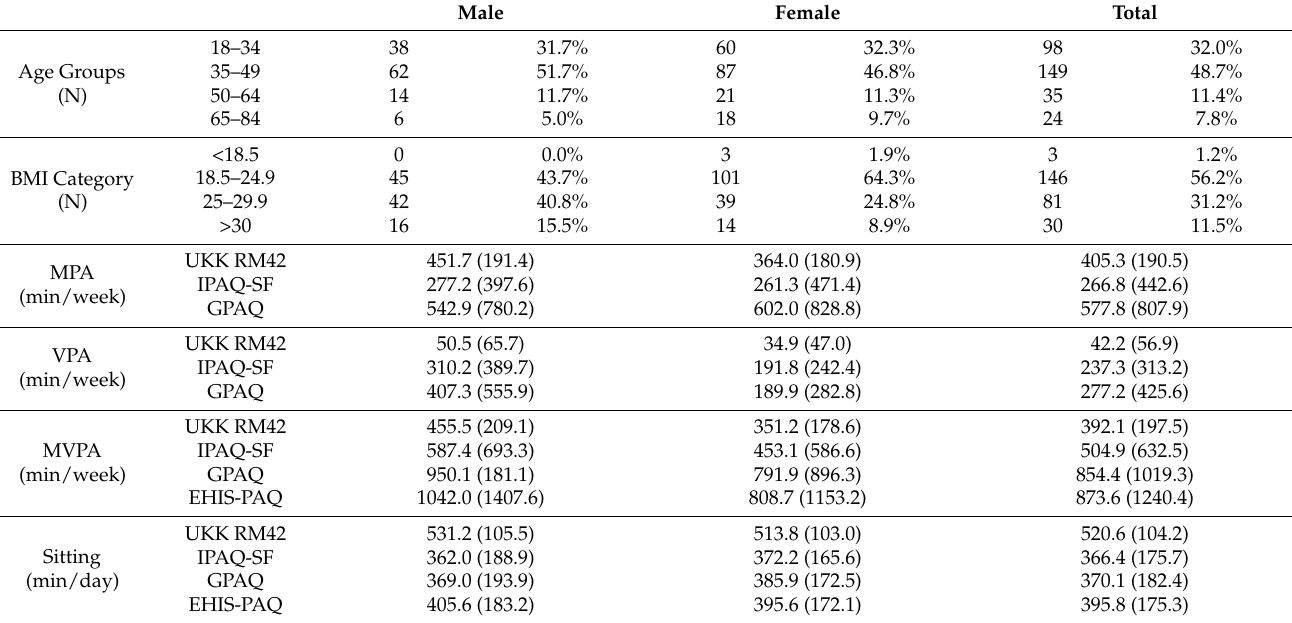
Table 1. Descriptive statistics of the